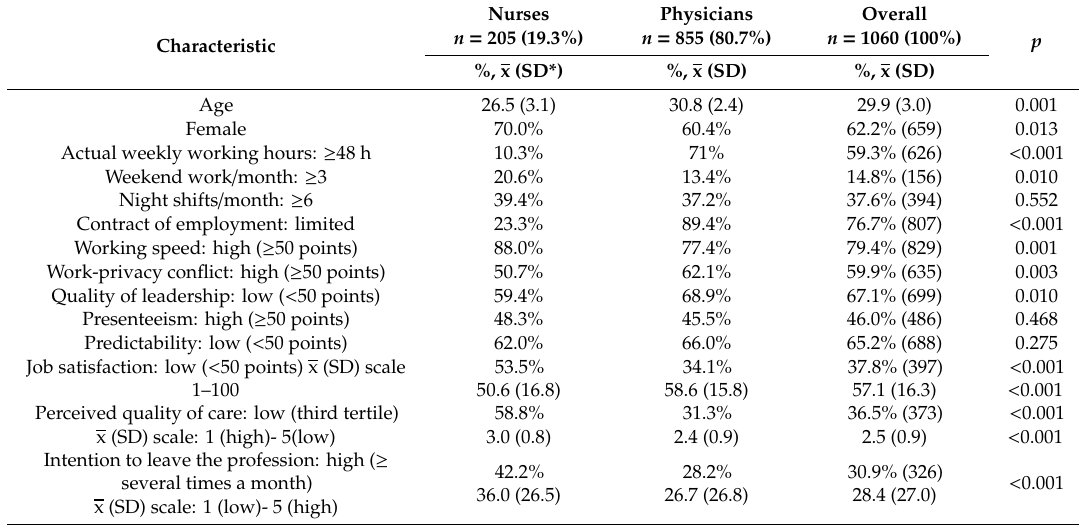
Table 1. Demographic and work-related characteristics of the sample.